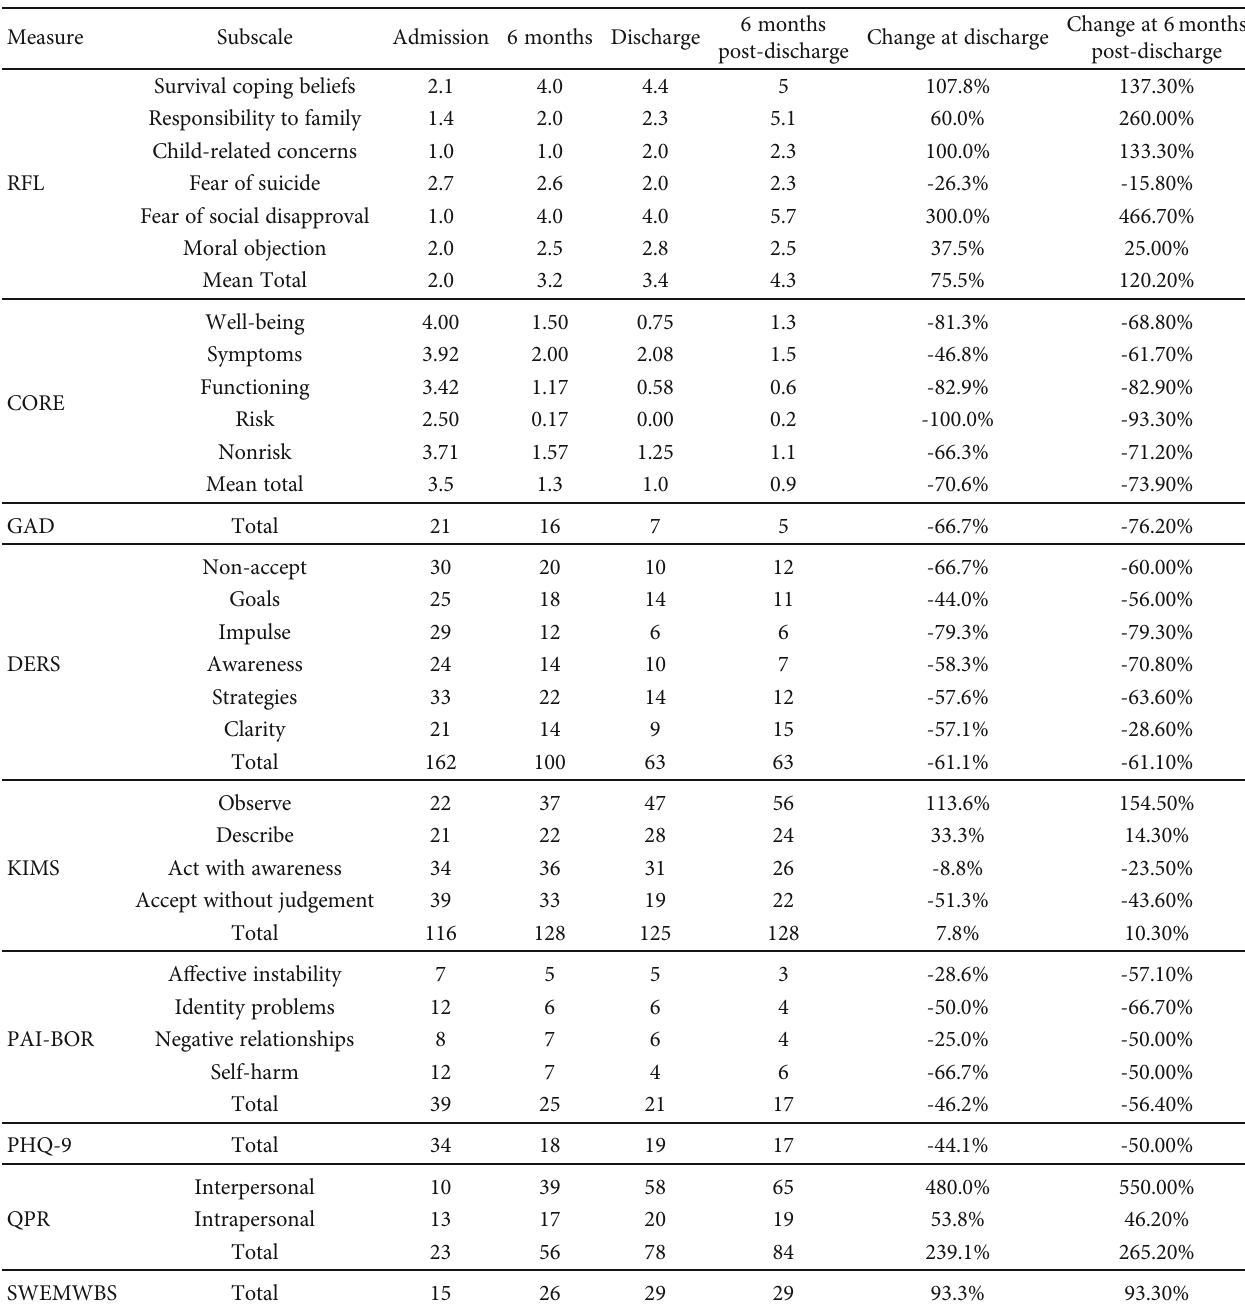
Table 1: Outcome measure results on admission, six months after admission, at discharge and six months post-discharge. “ A ” showed improvement along all outcome measures at the point of discharge, compared to scores on admission. This change persisted at follow-up. RFL (Reasons for Living Scale), CORE (Clinical Outcomes in Routine Evaluation), GAD (Generalised Anxiety Disorder 7-point scale), DERS (Di ffi culties in Emotional Regulation Scale), KIMS (The Kentucky Inventory of Mindfulness Skills), PAI-BOR (Personality Assessment Inventory for Borderline personality disorder), PHQ-9 (Patient Health Questionnaire), QPR (Process of Recovery Questionnaire), and SWEMWBS (Short Warwick Edinburgh Well-being